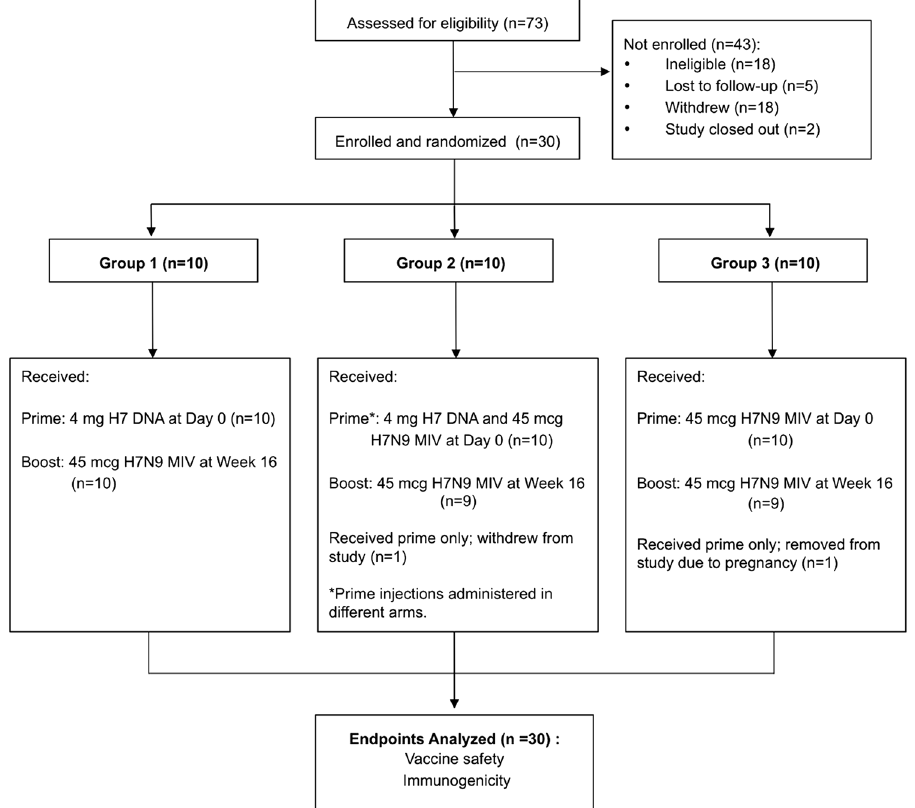
Fig. 1 CONSORT fl ow diagram of the trial. Consolidated standards of reporting trials (CONSORT) diagram delineates study enrollment of 30 subjects who were randomized to three study